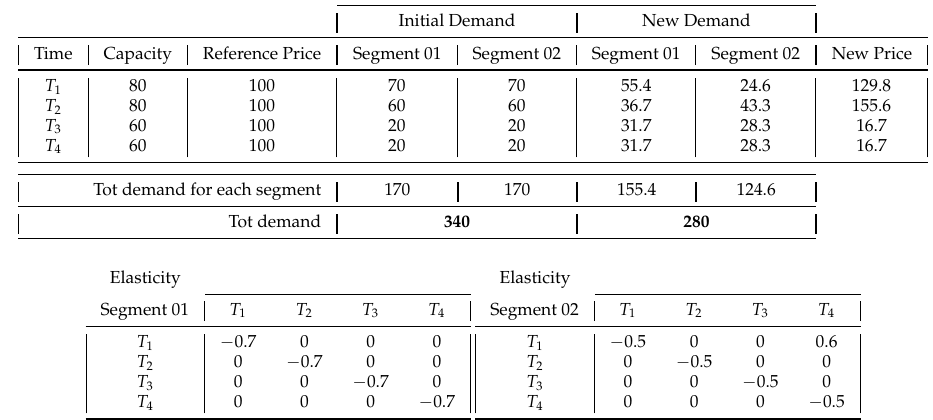
Table 11. Case Study 6.03—second sub-case, data, and